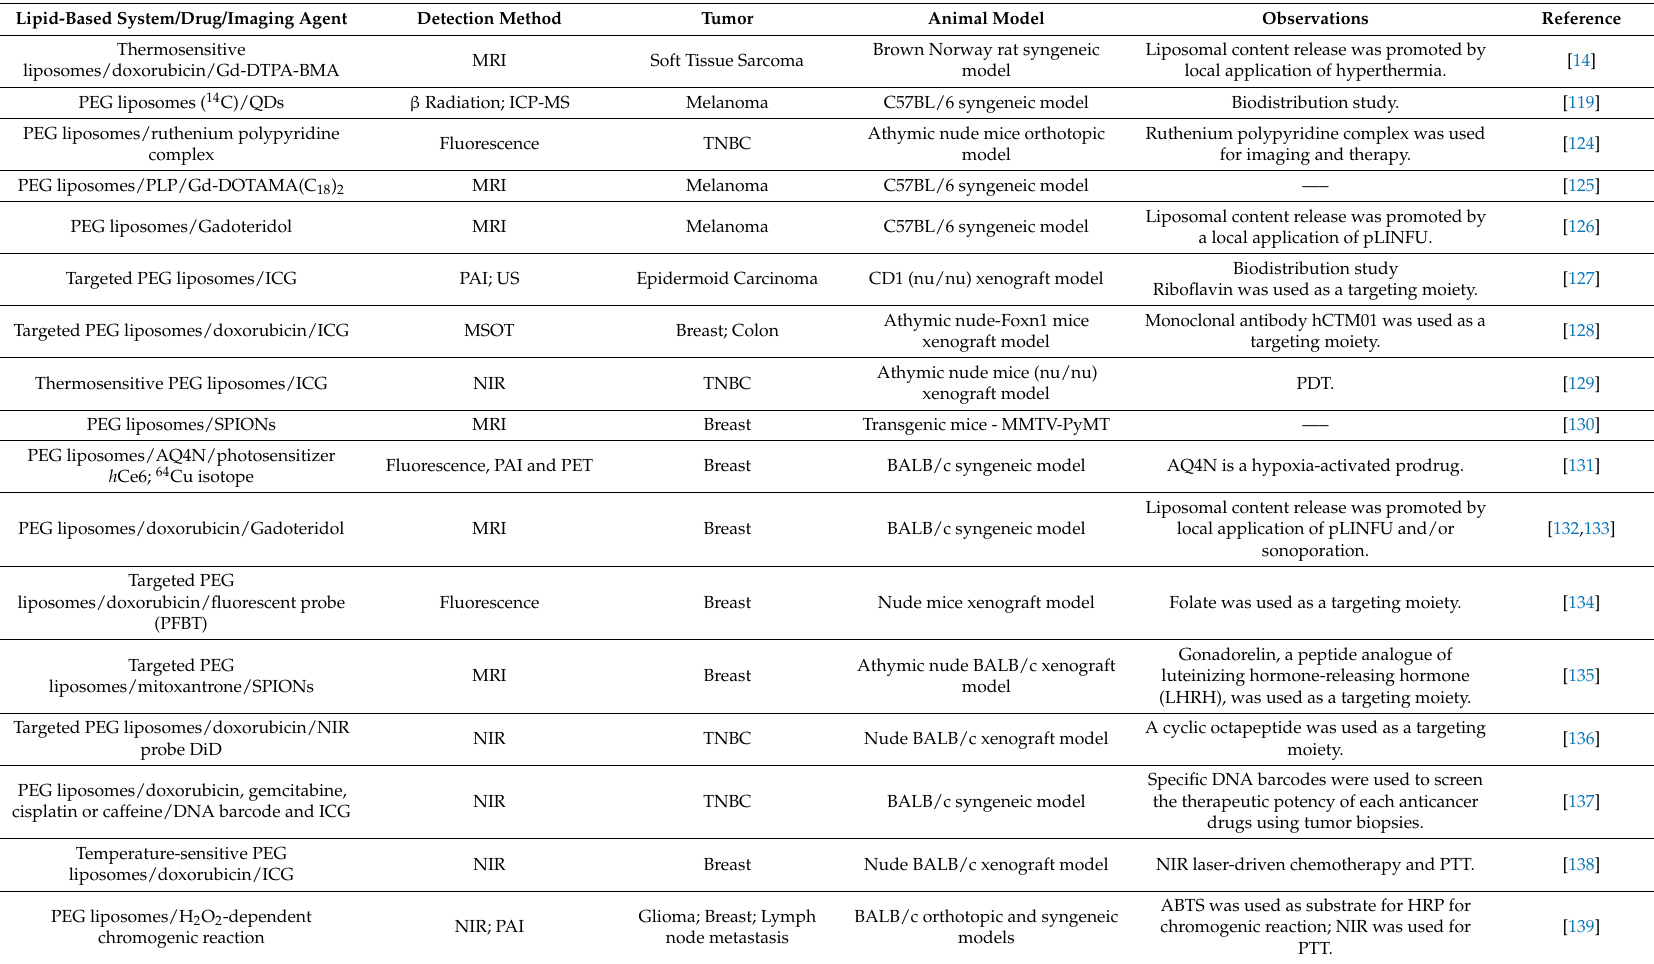
Table 2. Lipid-based nanotheranostic systems in a preclinical stage of